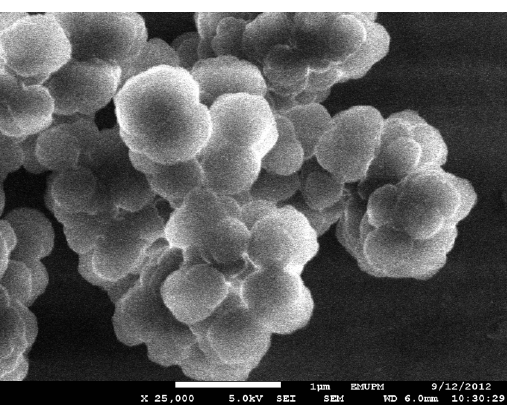
Figure 4. The Morphology of ( a ) Mel-MIP-9VC and ( b ) NIP-9VC using field emission scanning electron microscopy